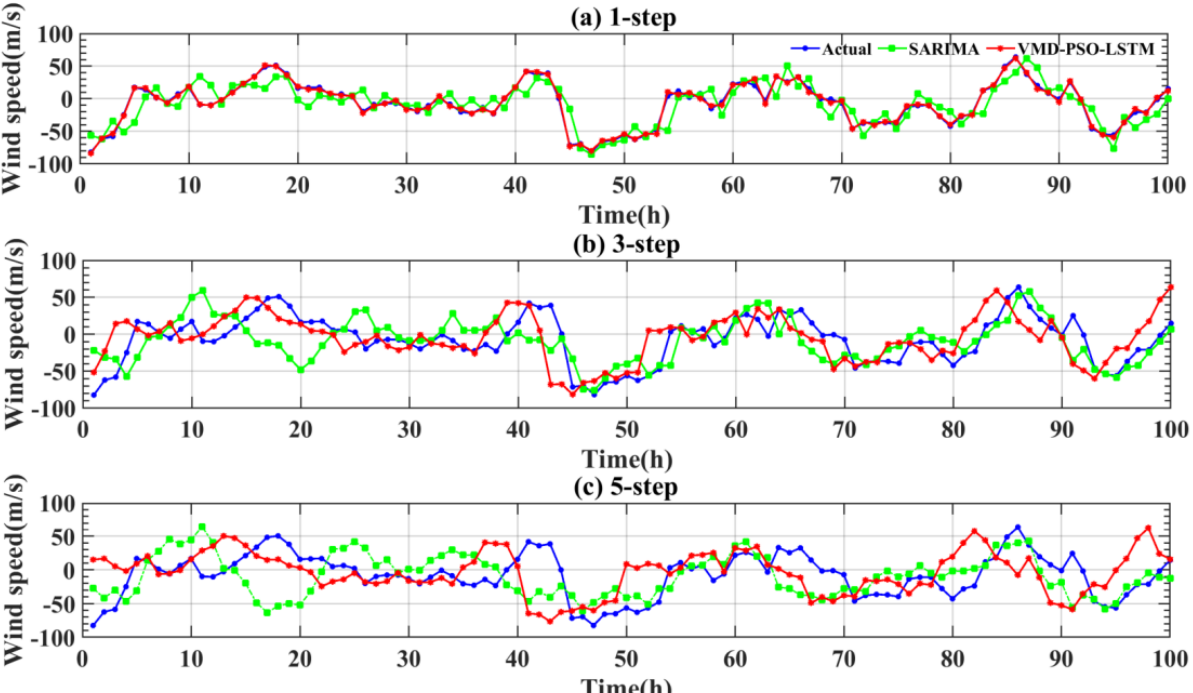
Figure 10. Comparison of SARIMA and VMD – PSO – LSTM prediction results, observations (blue line), SARIMA predicted value (green line) and VMD – PSO – LSTM predicted value (red line).